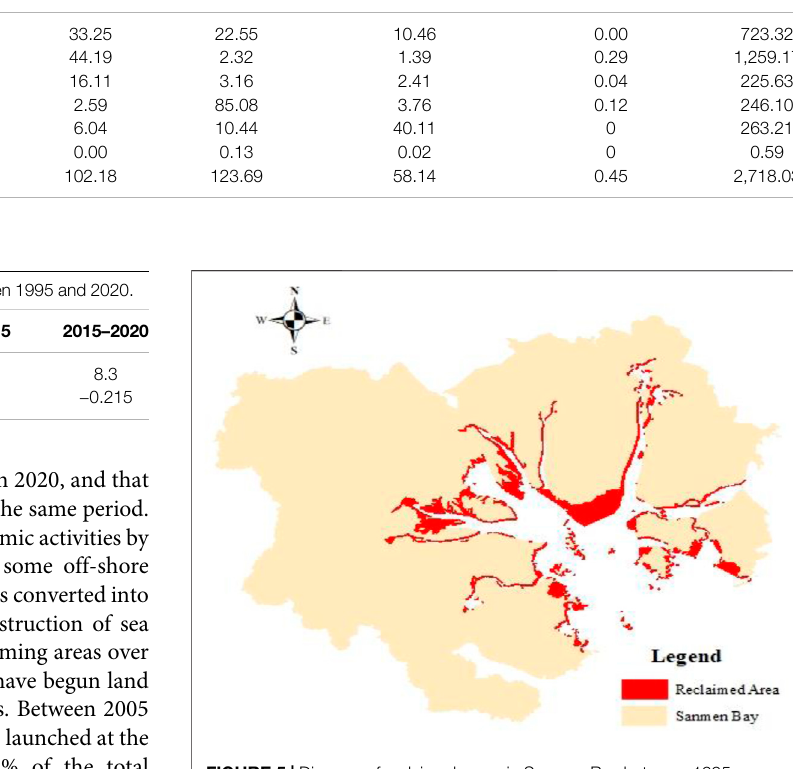
FIGURE 5 | Diagram of reclaimed areas in Sanmen Bay between 1995 and